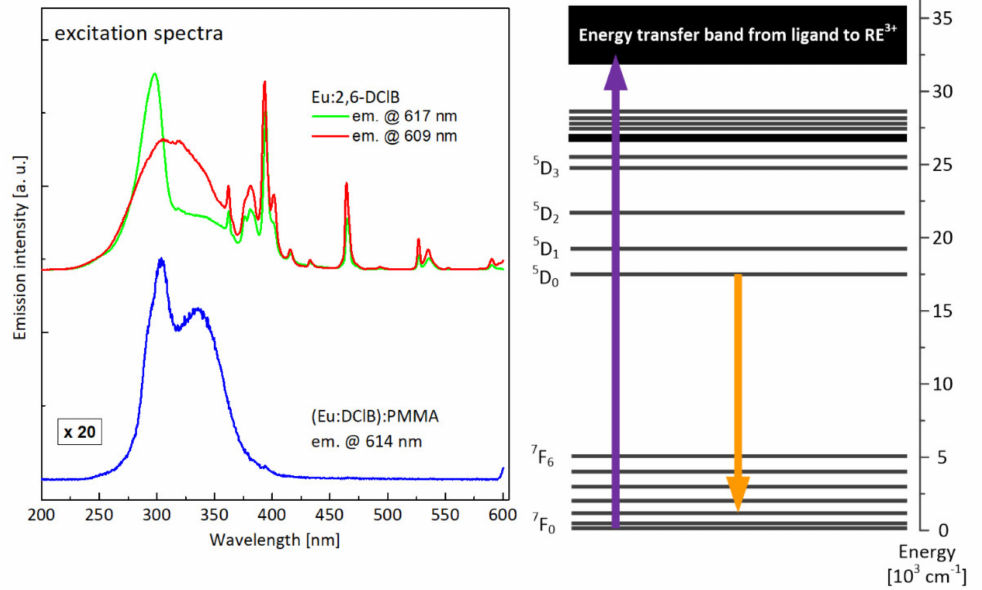
Figure 11. Comparison of the excitation characteristics recorded for the Eu:2,6-DClB complex and the Eu:2,6-DClB/PMMA polymer composite, together with the attribution of the monitored luminescent transition against the energy-level scheme of